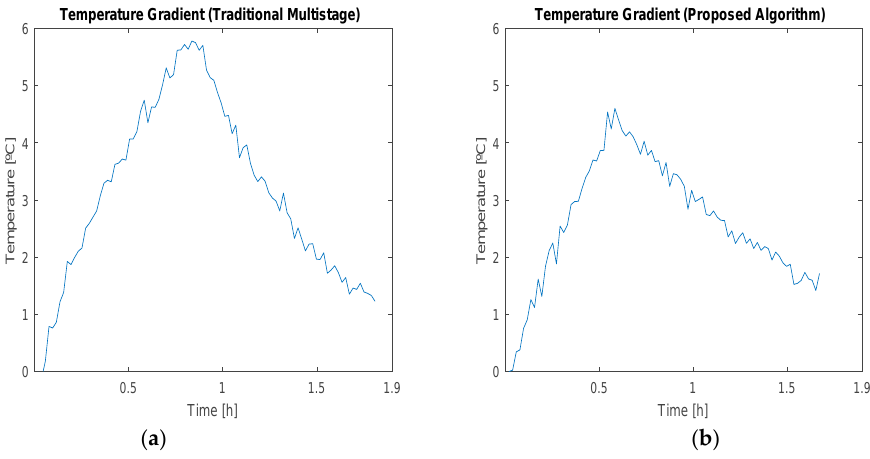
Figure 23. Temperature gradients during battery charging with ( a ) the traditional Multistage method and ( b ) the proposed method.